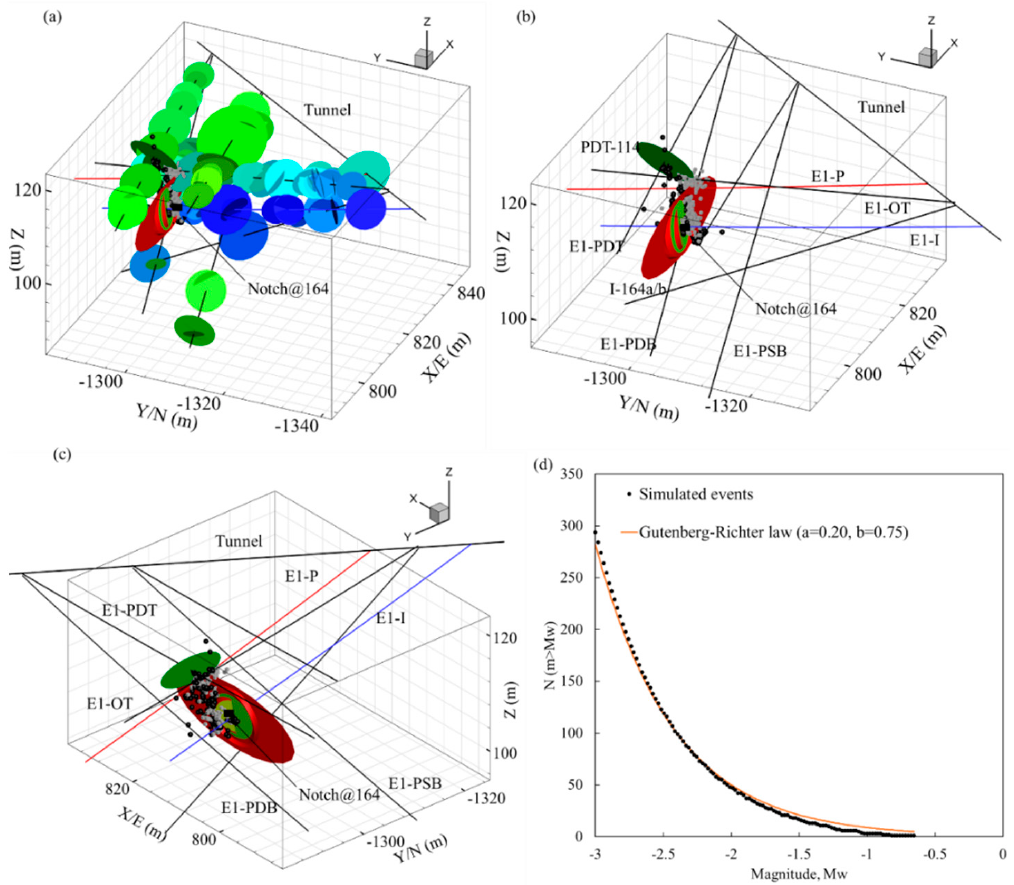
Figure 17. Comparison between simulated events with field-observed events. Black spheres represent field-observed seismicity and grey cubes represent the simulated seismicity. ( a – c ) The distribution of simulated events and field-observed events. ( d ) The magnitude-frequency distributions and seismic b -values for simulated seismicity; b -values is predefined, and a-values is a fitting pa- rameter.